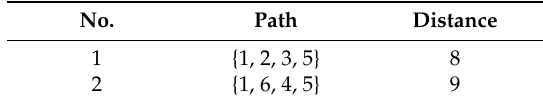
Table 2. The selected dual paths from source 1 to destination